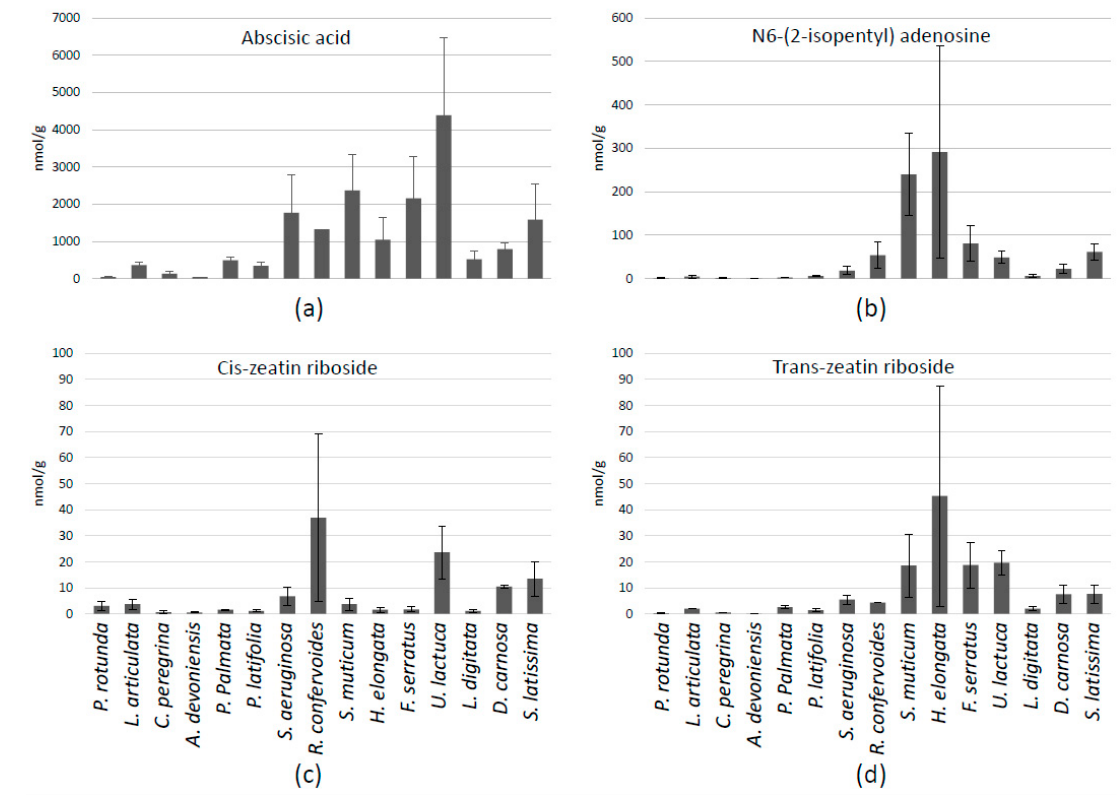
Figure 1. Levels of four phytohormone levels in South West seaweeds (SD error bars shown). ( a ) abscisic acid (ABA); ( b ) N6-(2-isopentyl) adenosine (2iP ( c ) cis-zeatin riboside; ( d ) trans-zeatin riboside (TZR).